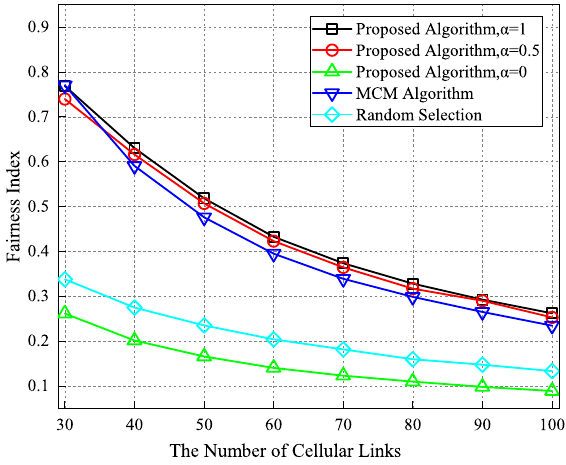
Figure 6. The fairness performance of different schemes with varying V2I links.